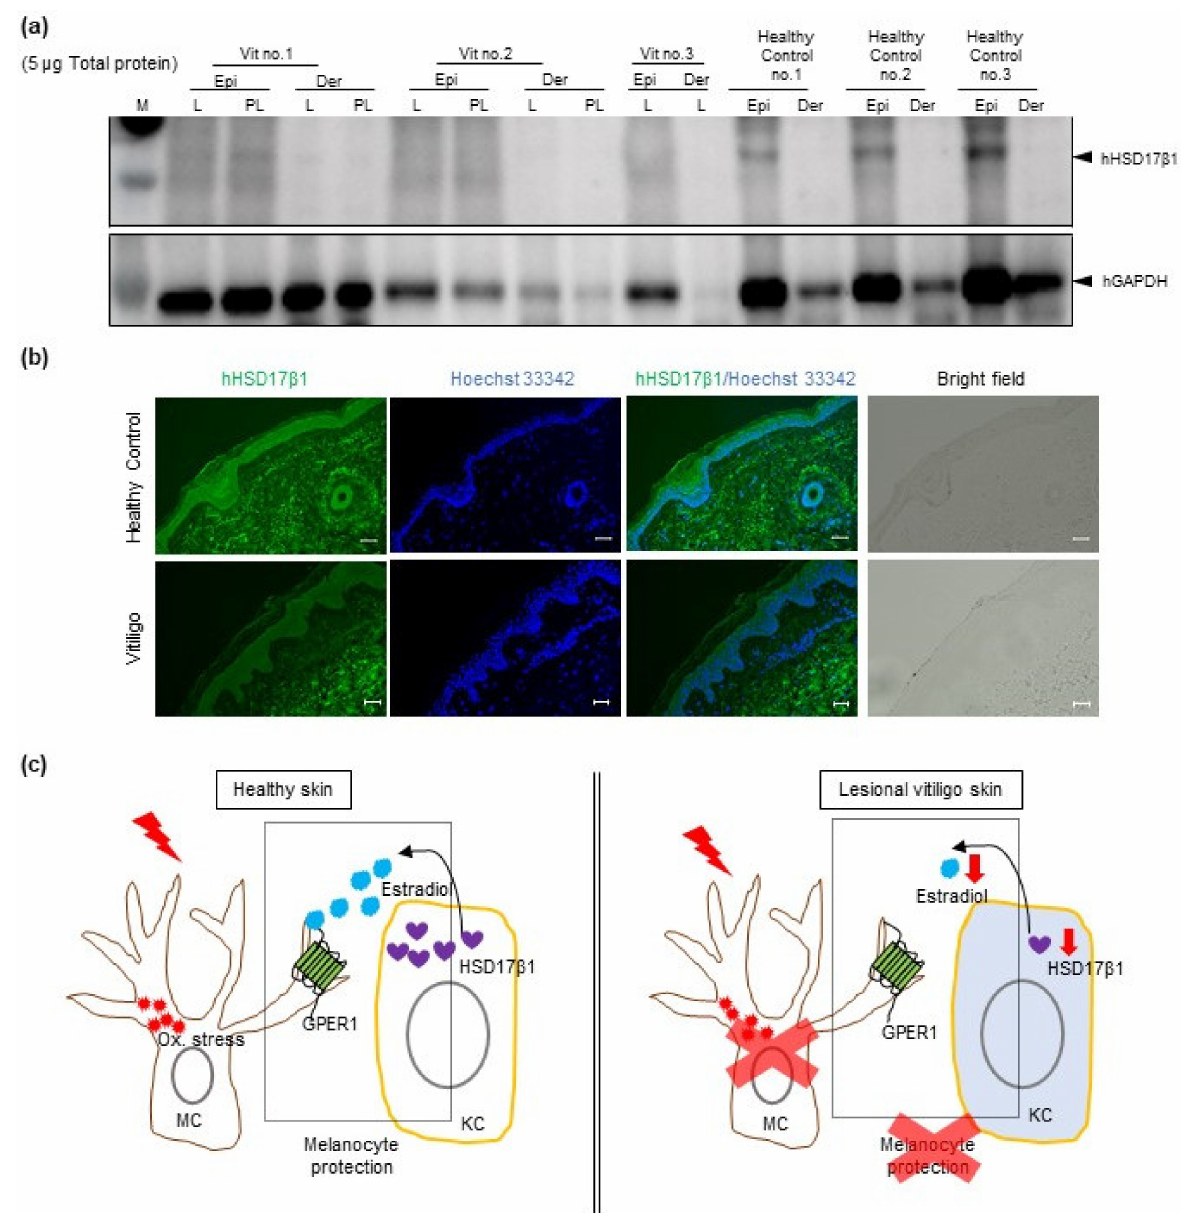
Figure 6. Estrogen synthesis enzyme HSD17 β 1 is reduced in skin epidermal keratinocytes of vitiligo patients. ( a ) Western blot analysis of 5 µ g protein from vitiligo patients and healthy controls. Vit., vitiligo patient; Epi., epidermis; Der., dermis; L., lesional skin of vitiligo; PL., perilesional skin of vitiligo. ( b ) Representative sections of skin from healthy donors and vitiligo patients stained by the anti-HSD17 β 1 antibody (in green) and Hoechst 33342 (in blue) are shown. The corresponding bright-field microscopy image is shown in the lower panel. White bar, 100 µ m. ( c ) Summary illustration of the possible involvement of local estrogen in vitiligo development. KC, keratinocytes; MC,